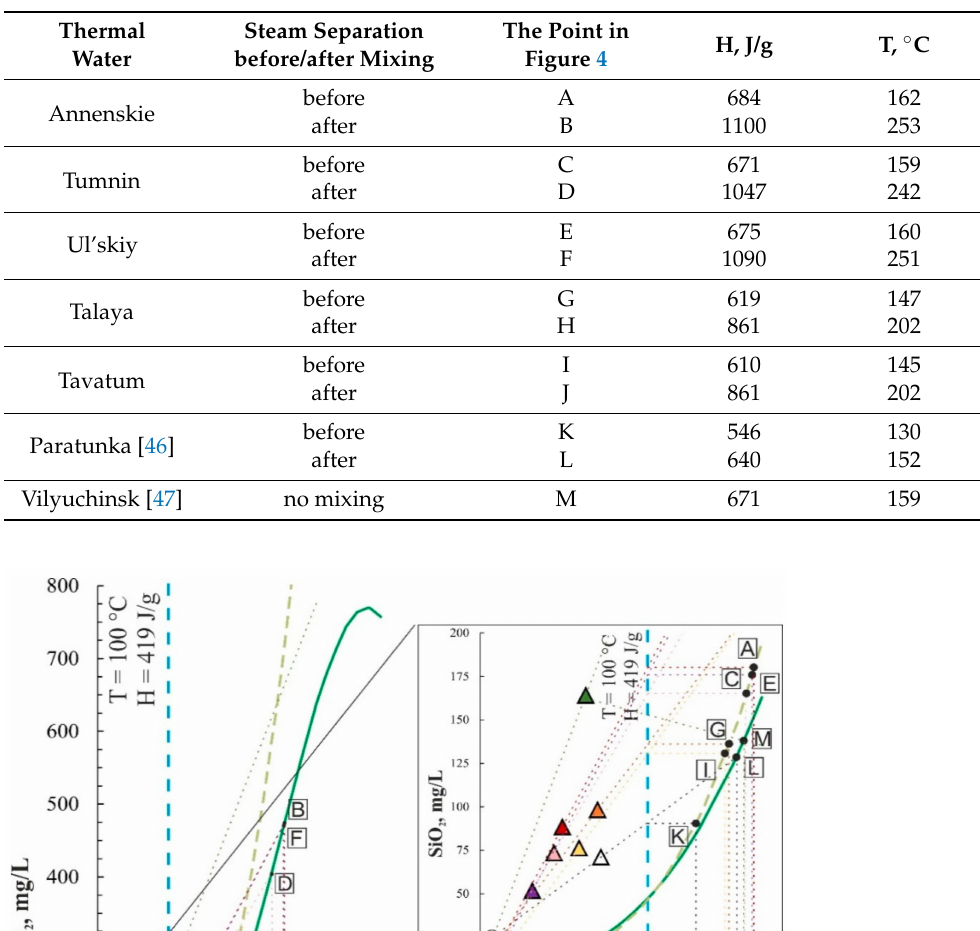
Table 3. Results of the reservoir temperature estimation using the Si-enthalpy mixing model.